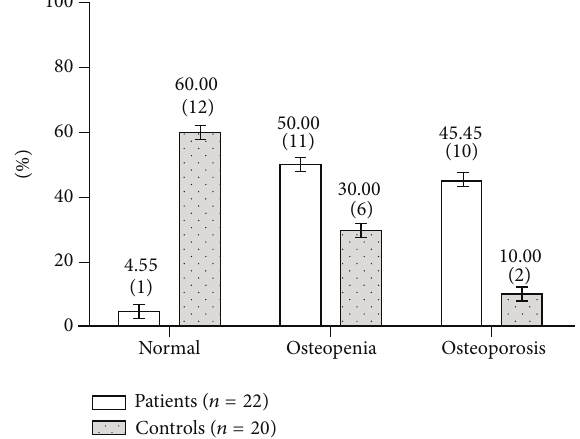
Figure 1: The prevalence of osteoporosis in patients and controls given as %( 𝑛 ).